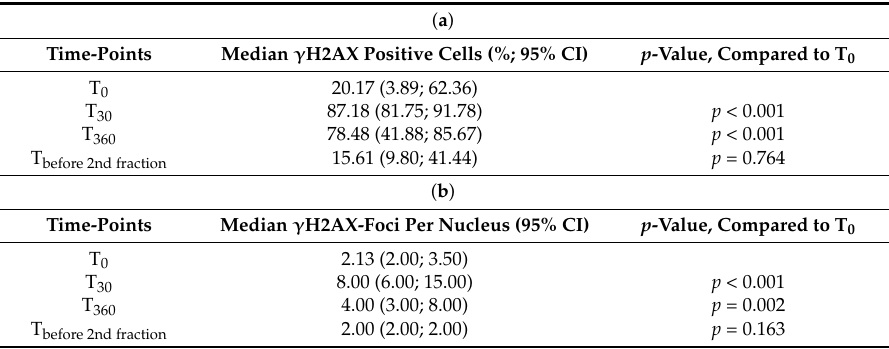
Figure 3. Time-course of γ H2AX immunohistochemical labeling in normal epithelium, soft tissue sarcoma, and malignant melanoma. All tissues show low γ H2AX reactivity before radiotherapy, high numbers of γ H2AX positive cells and foci per cell at 30 min after radiotherapy, and a decrease of the respective numbers at 360 min after radiotherapy. (RT = radiotherapy; bars: overview 20 μ m, insert 15 μ m); (Immunoperoxidase, haematoxylin-conterstain: brown intranuclear dots represent γ H2AX-foci). Table 2. ( a ) Positive staining for γ H2AX-foci (%). T 0 , T 30 , T 360 , etc. indicate the time-points in minutes after completion of radiation treatment. ( b ) Number of γ H2AX-foci per positive cell. T 0 , T 30 , T 360 , etc. indicate the time-points in minutes after completion of radiation treatment. Time-Points Median γ H2AX Positive Cells (%; 95% CI) p -Value, Compared to T 0